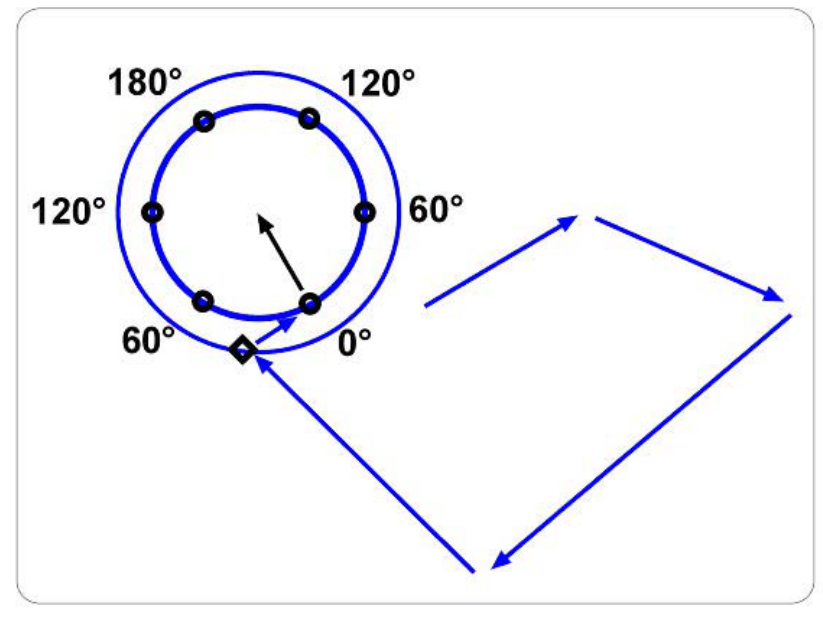
FIGURE 1 . Following a sequence of search saccades (shown as arrows) one black annulus probe stimulus was displayed at any one of 6 equally spaced locations centered on the current fixation (shown at the terminus of the final black arrow). In the one-back condition, illustrated here, the immediately preceding fixation was one of the 6 randomly selected probe locations (along the inner blue circle), which are labeled according to their angular distance from the one-back fixation. In the two-back condition, the probes would have been placed along the outer blue circle with the 0 degree probe at the two-back fixation (shown by the diamond). Klein & MacInnes [1] used both the one- and two -back conditions. Only the one back condition was used here.